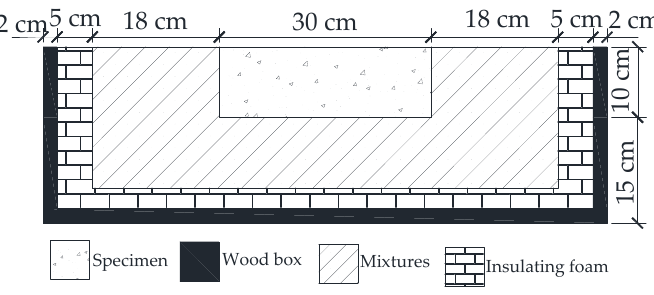
Figure 3. Schemes of testing box.